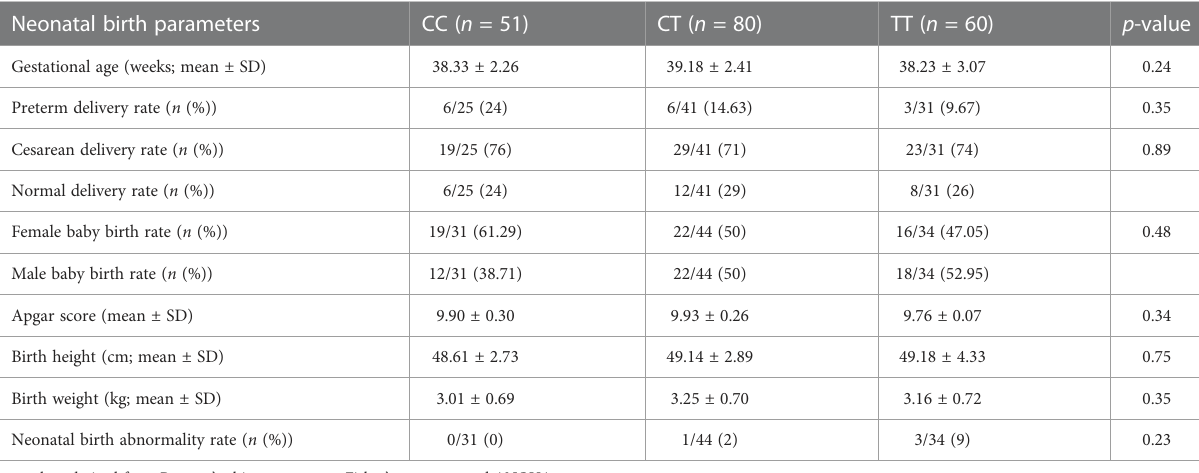
TABLE 5 Neonatal outcomes in association with MTHFR polymorphism.